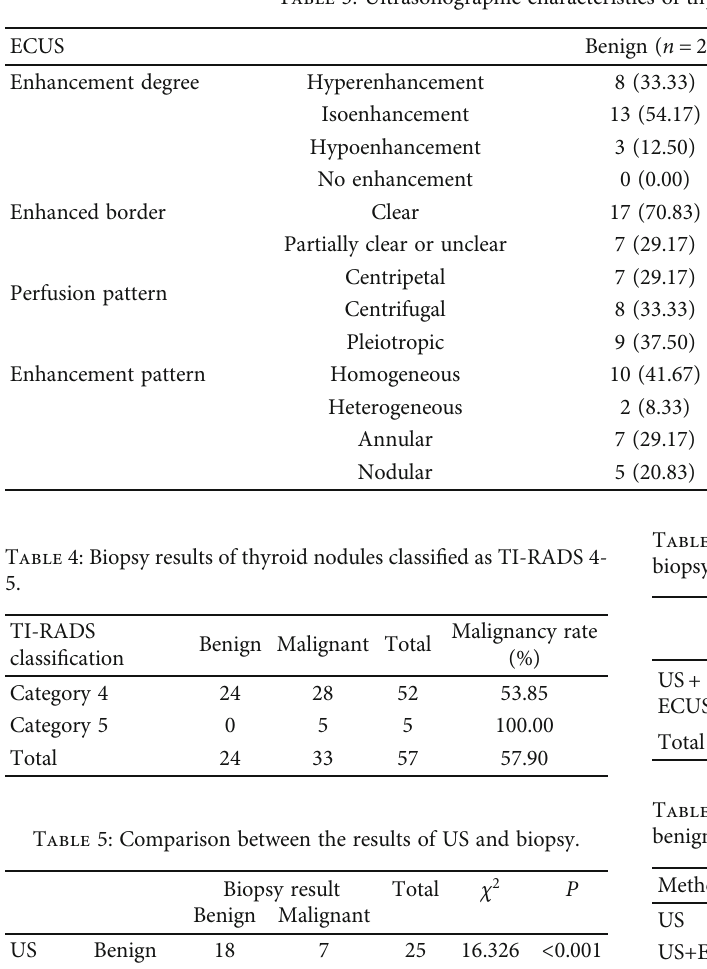
Table 3: Ultrasonographic characteristics of thyroid nodules (ECUS) [ n ð % Þ ].